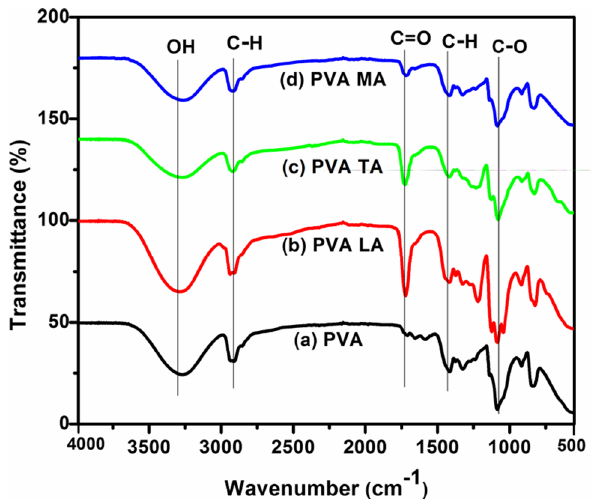
Fig. 2 FTIR spectra for pristine PVA and cross-linked PVA